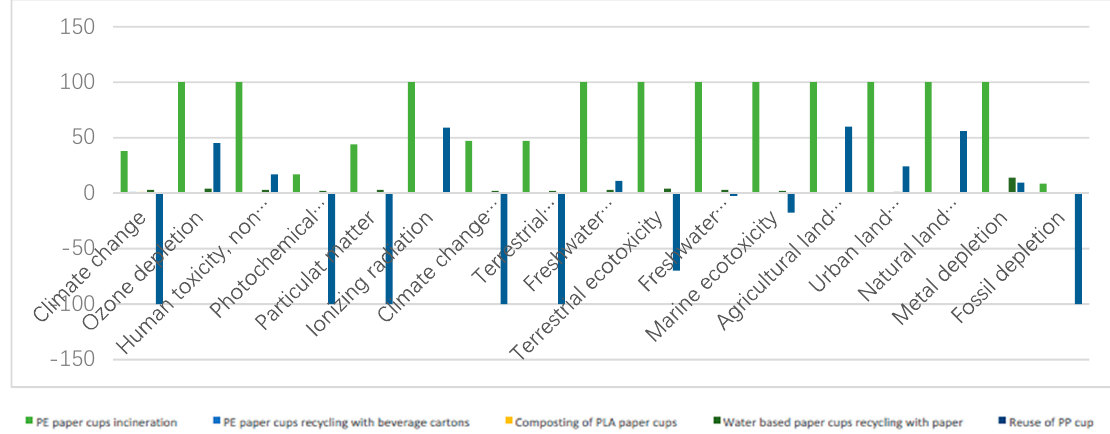
Figure 4. Midpoint results of five different cup scenarios for production and waste treatment.